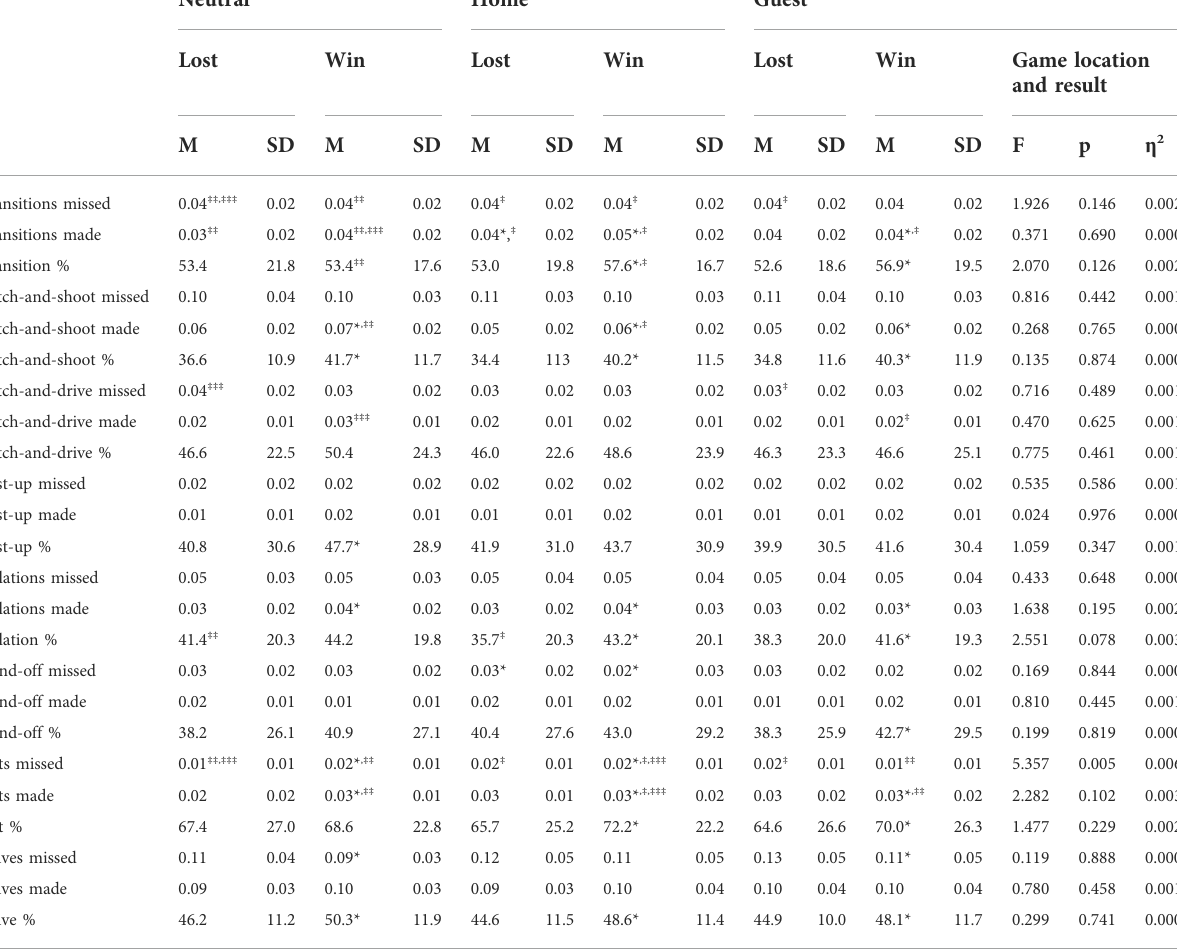
TABLE 3 Results of pre-shot combinations (per possession). Neutral